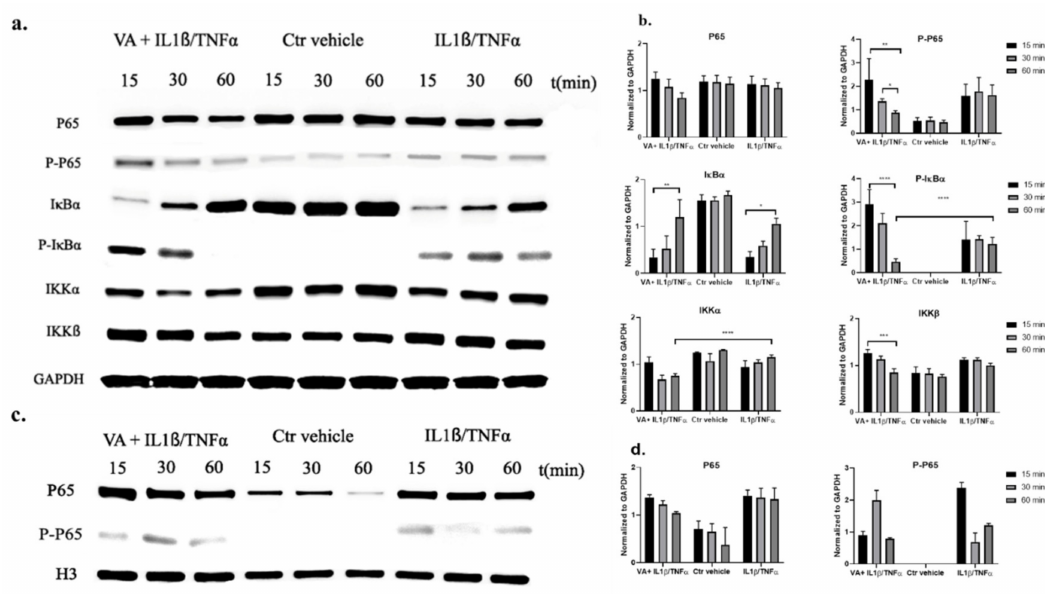
Figure 10. The expression of the main proteins in the NF- κ B signaling pathway including I κ B kinase (IKK α ), IKK β , NF- κ B (P65), P-NF- κ B (P-P65), I κ B α , P-I κ B α in treatment groups with VA versus untreated control groups was determined by Western blot analysis. Glyceraldehyde 3-phosphate dehydrogenase (GAPDH) was used as endogenous control. After induction of inflammation with 1 ng / mL IL-1 β / TNF- α in human OA chondrocytes, the cells were either simultaneously treated with